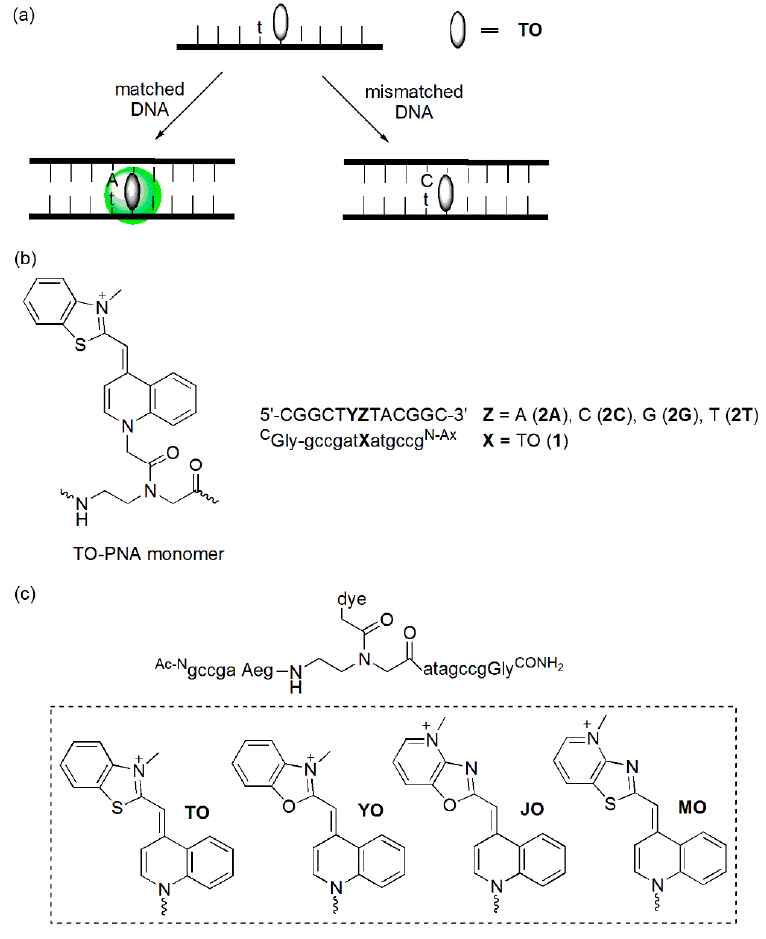
Figure 4. ( a ) Principle of FIT-probes; ( b ) TO -PNA conjugate; and ( c ) TO -, YO -, MO -, and JO -PNA conjugates.